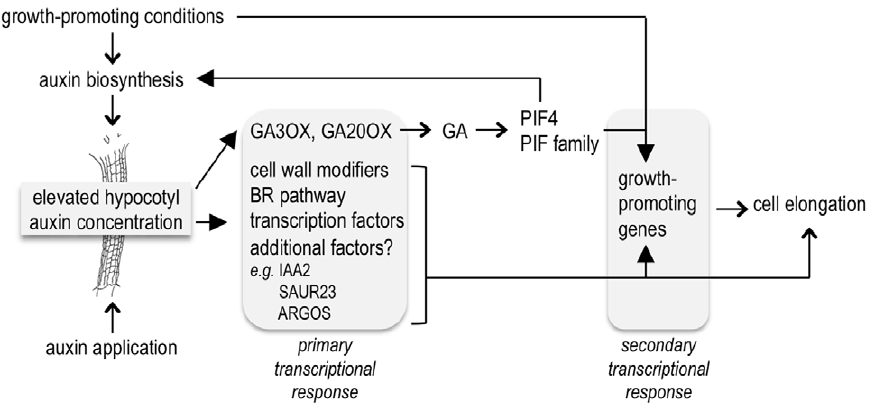
Figure 7. Model for the transcriptional auxin response preceding hypocotyl elongation. Auxin levels in hypocotyl tissue elevate in response to growth-promoting conditions or exogenous auxin, which activates transcriptional auxin signaling. Early auxin-responsive genes include those encoding GA oxidases, cell wall modifying enzymes, and other factors that may contribute directly to cell elongation or regulate expression of additional growth-promoting genes. These pathways may be reinf orced by activity of PIF4 and PIF5, which are liberated from DELLA repression due to auxin-mediated modulation of GA levels. In growth-promoting conditions, auxin-responsive genes may be PIF-dependent due to PIF regulation of auxin biosynthesis [39,42,77,87].